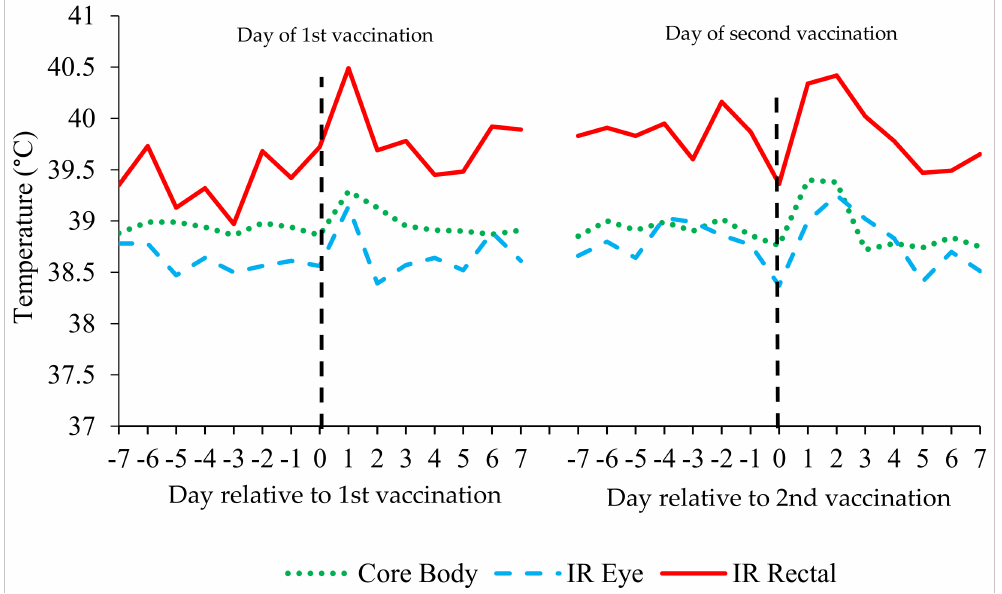
Figure 2. Core body temperature as measured via digital rectal thermometer, IR eye and IR rectal temperature of calves over the periods of 1st and 2nd vaccination.